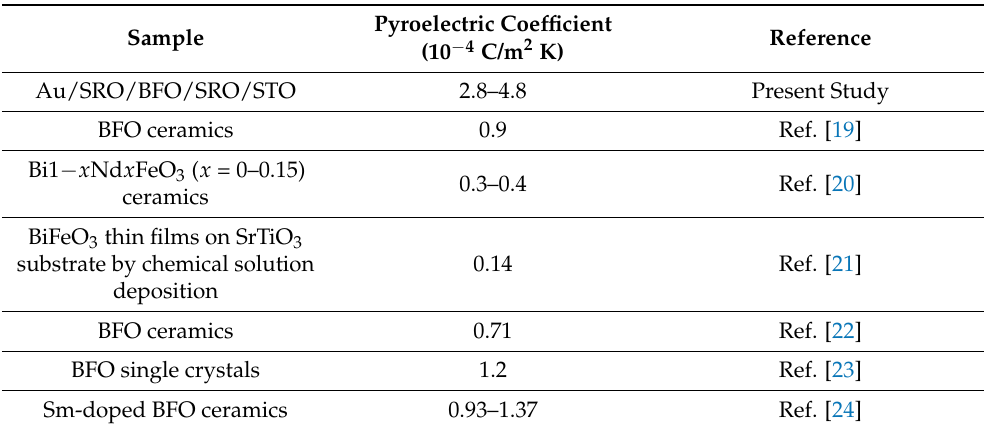
Table 2. Comparative values for the pyroelectric coefficient of BFO (present study and previous reports in the